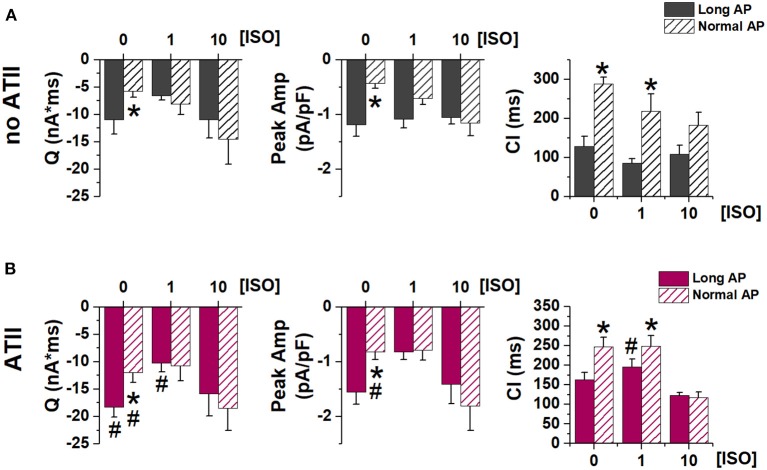
Effect of APD shortening on ITI properties. Statistics (mean ± S.E.) of ITI charge (Q), peak ITI amplitude (Peak Amp) and coupling interval (CI) (A) in the absence of ATII (no ATII); (B) in the presence of ATII (ATII). N > 8 for all groups. *p < 0.05 vs. Long AP; #p < 0.05 vs. no ATII CMs.